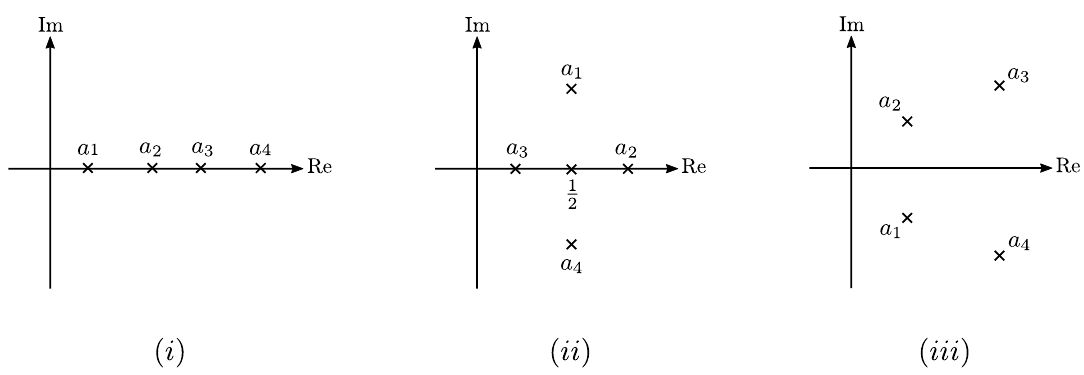
Figure 1 . Three possible con(cid:12)gurations of the branch points in the complex plane such that y 2 = P 4 ( x ) 2 R . ( i ) All branch points are real and ordered. ( ii ) Two branch points are real and two branch points are complex conjugate to each other. ( iii ) All branch points are complex and pairwise complex conjugate to each